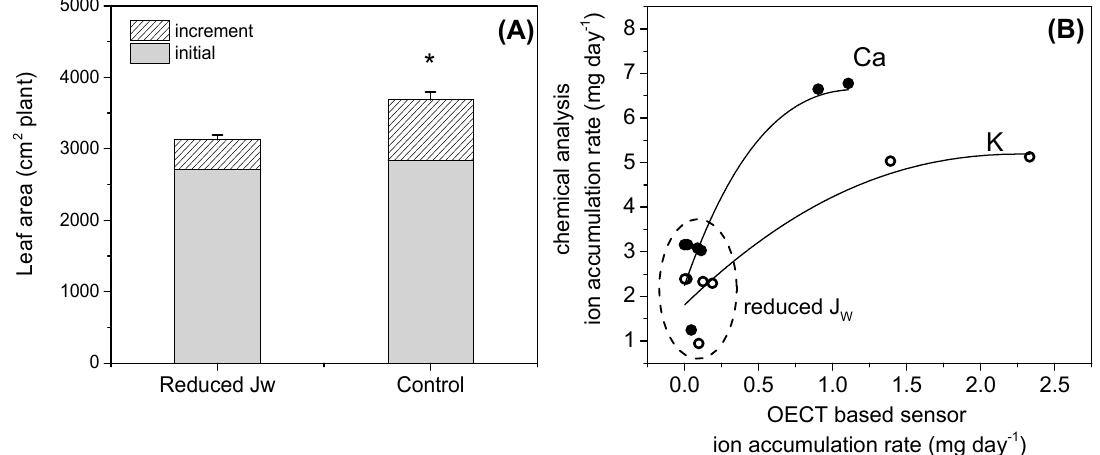
Figure 11. ( A ) Average leaf area per plant (± SE) measured at beginning and at the end of the experiment in trees under regular (control) and reduced Jw. The increment of leaf area has been determined as the difference between initial and final values. Comparing the increment of leaf area between treatments, * indicates statistically significant differences. ( B ) Accumulation rate (mg day 1) of Ca (•) and K ( ○ ) as determined through the OECT values of sap concentration and through the chemical analysis of the dry mater of new developed leaves with a 2 weeks’ period. Note that dash circled (cid:35) values have been sampled from trees under reduced Jw.